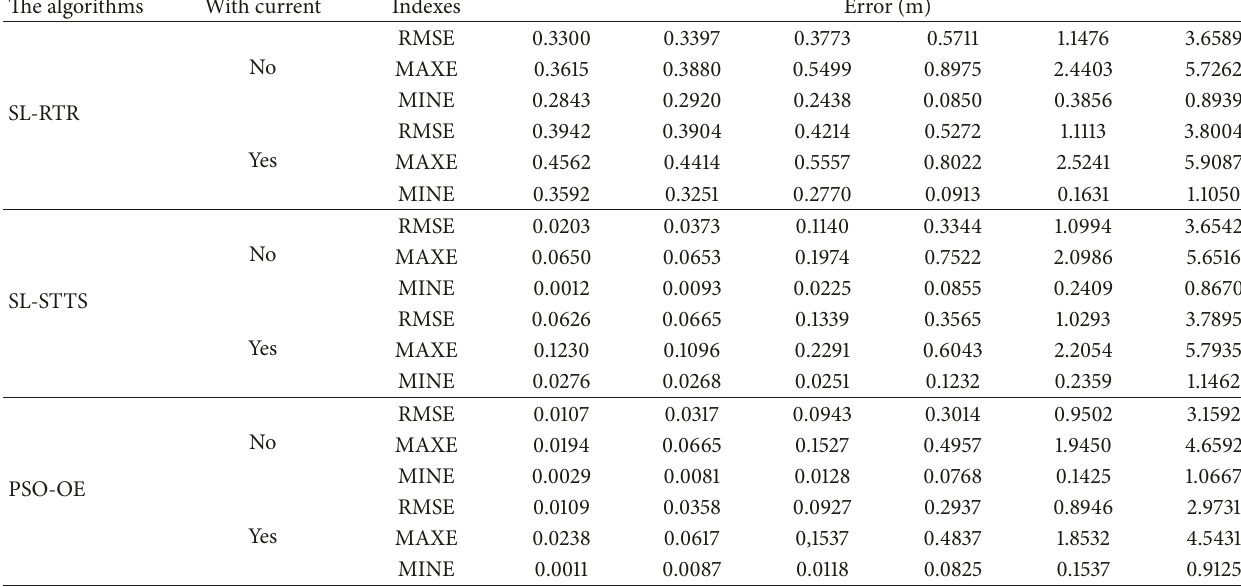
Table 2: The localization error of the localization task by different distance measurement noise level.